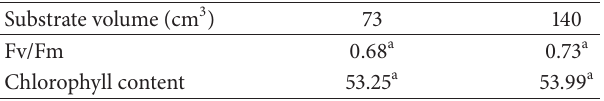
Table 1: Effect of substrate volumes on chlorophyll fluorescence efficiency (Fv/Fm) and chlorophyll content.